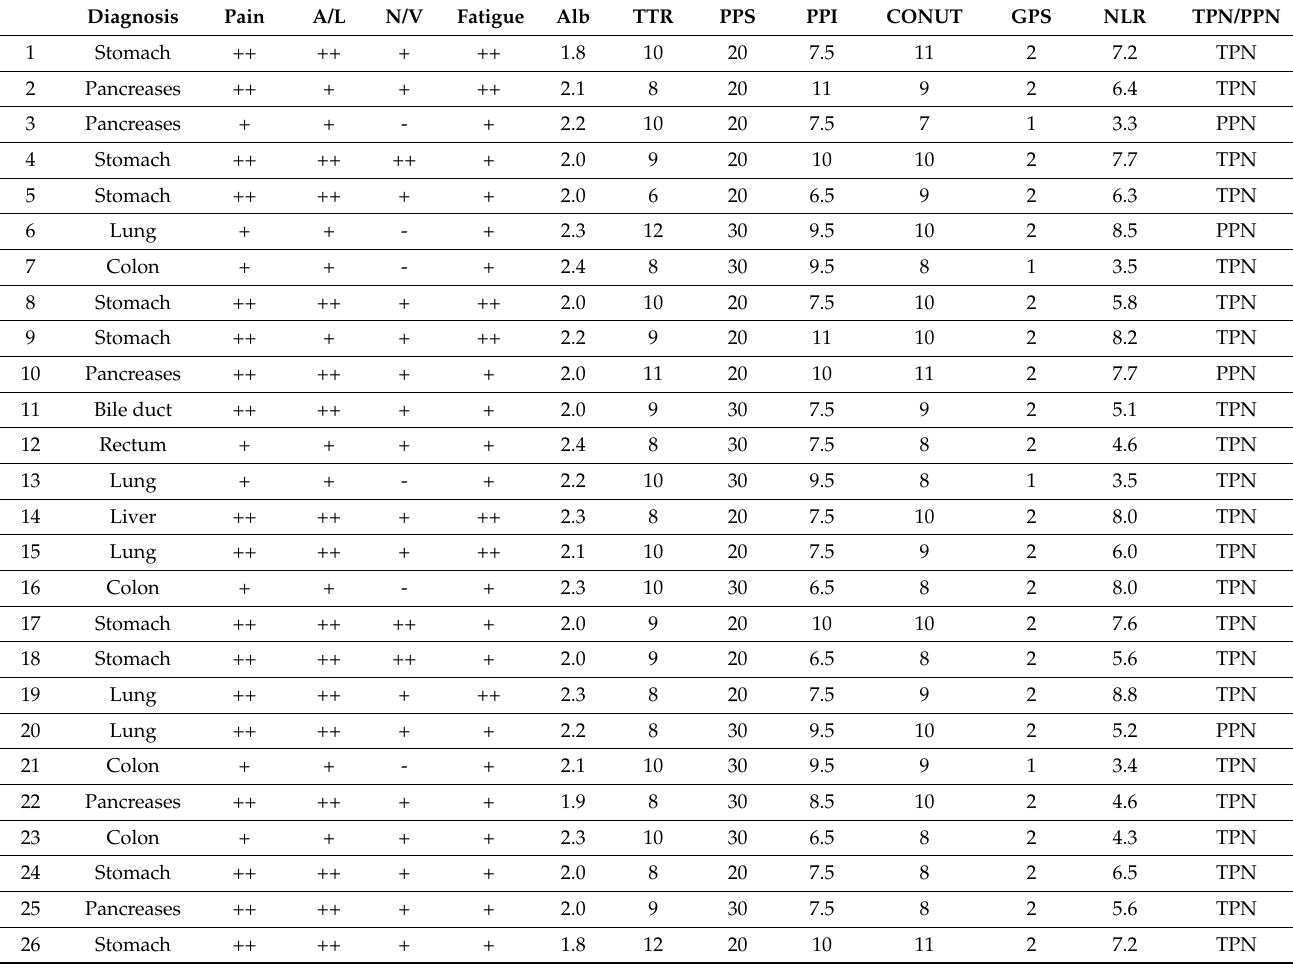
Table 1. Patients’ characteristics on admission.